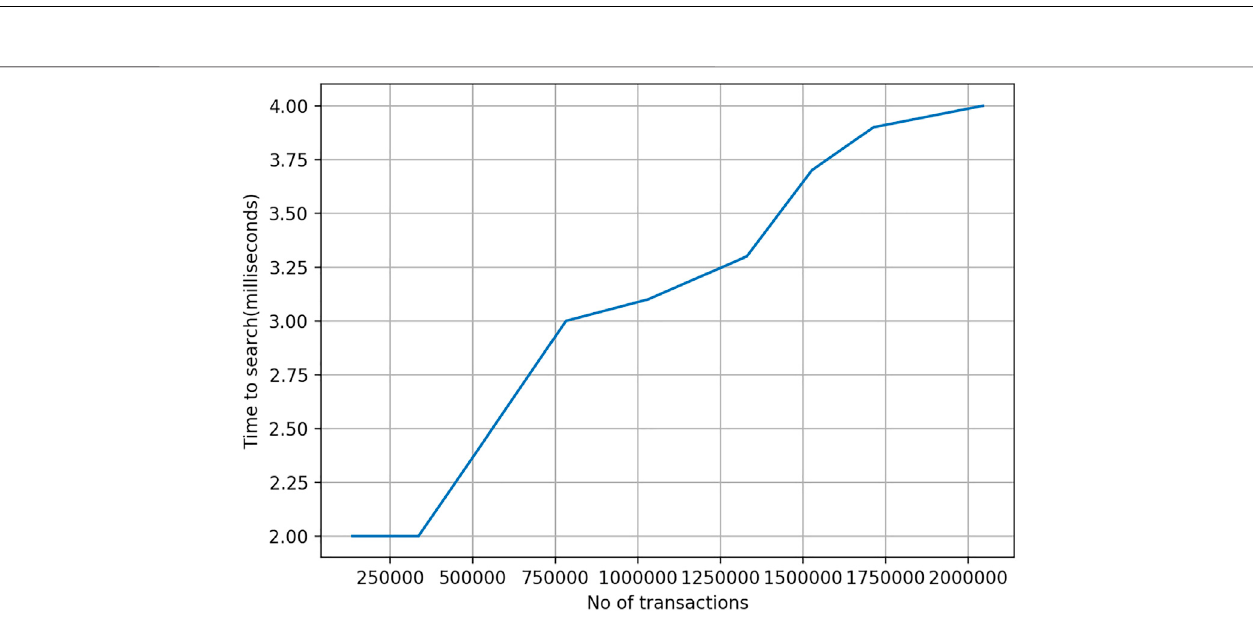
FIGURE 11 | Transaction/asset search performance in the Vind blockchain platform.